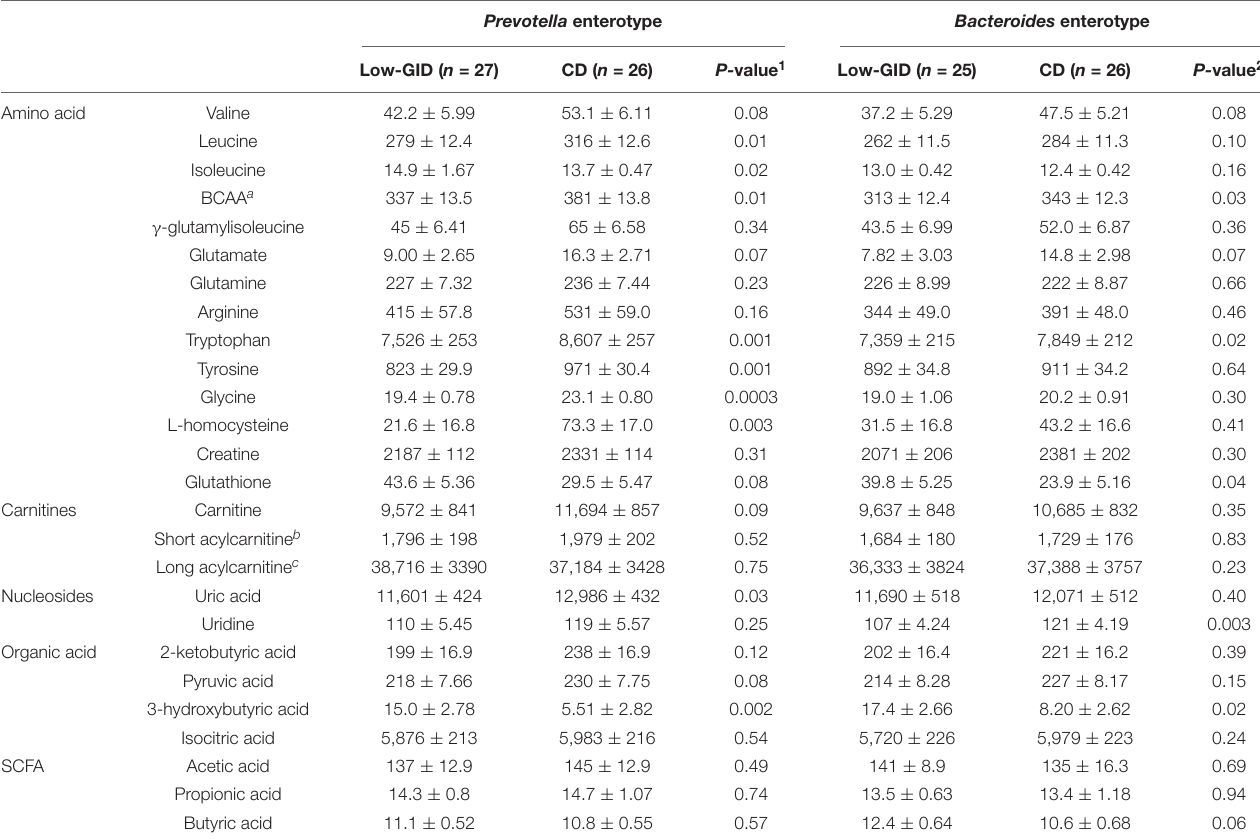
TABLE 4 | Serum metabolites of the participants according to Prevotella and Bacteroides enterotypes after a low-glycemic diet (Low-GID) representing Korean traditional balanced diet and westernized diet as a control diet